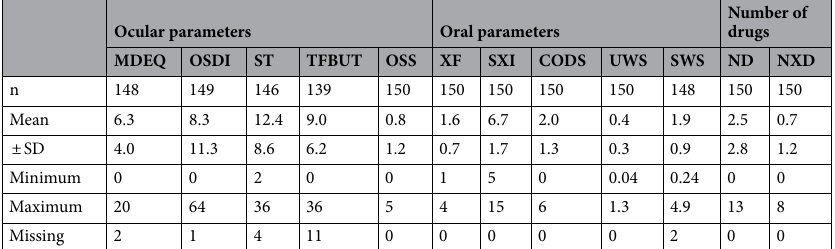
Ocular parameters Oral parameters